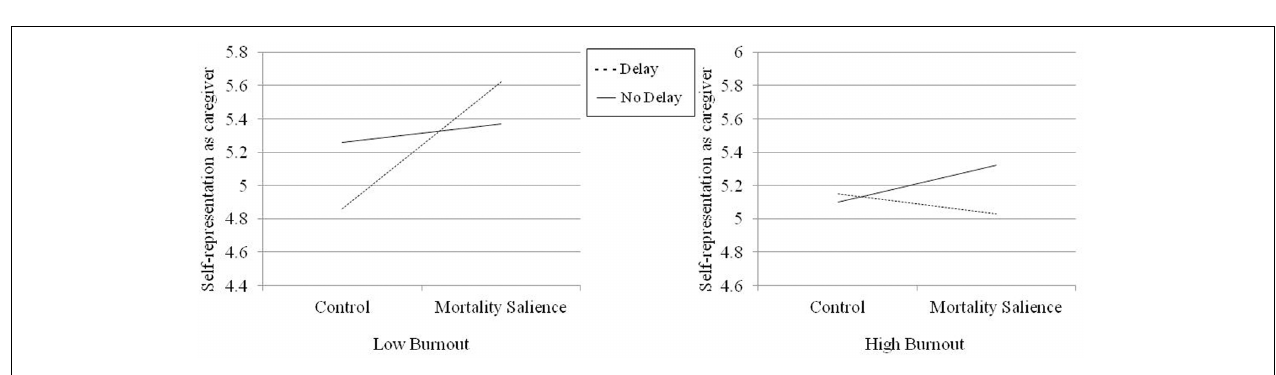
FIGURE 2 | Work self-efficacy as a function of MS and delay at low and high levels of burnout.